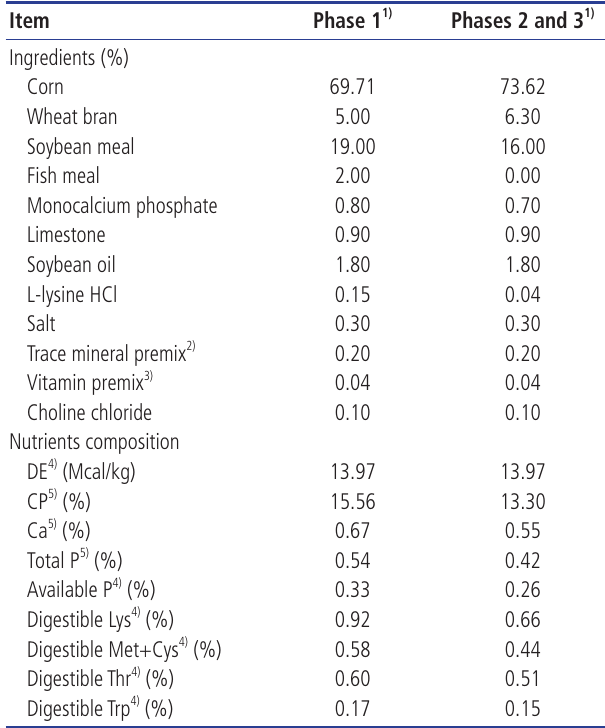
Table 1. Ingredients and nutrient compositions of basal diets (DM basis)